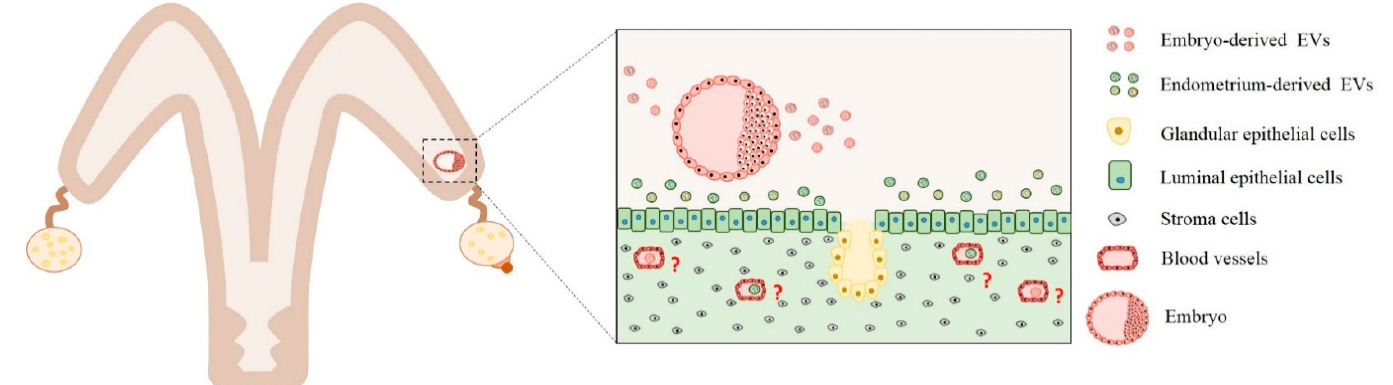
Figure 1. Embryo–maternal interactions mediated by extracellular vesicles secreted from the embryo and endometrium cells. Extracellular vesicles secreted by embryos are uptaken by endometrial cells. Extracellular vesicles (EVs) content include miRNA, mRNAs, and proteins that act by paracrine signaling. Different experiments demonstrated that embryo-derived EVs can modulate interferon-tau, apoptosis, cell proliferation, adhesion, angiogenesis, and cell survival biological pathways. Similarly, endometrium cells can secret EVs containing proteins, miRNAs, and mRNAs. These EVs are uptaken by trophoblast cells, and their contents are predicted to regulate interferon-tau production and angiogenesis pathways. However, questions related to how embryo-derived EVs can exit the uterus and arrive in other maternal tissue cells are yet unclear (red interrogation points). Therefore, further studies are needed to understand how the factors secreted by the embryos exit the uterus and to arrive in other maternal tissue, as blood cells, to modulate biological pathways.